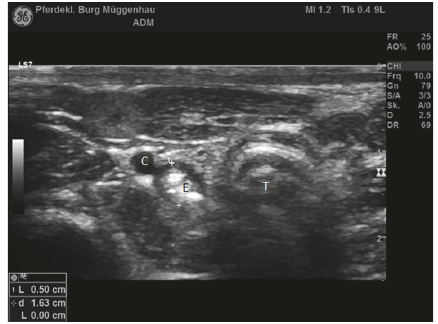
Figure 3: Ultrasound image of the stricture site. Left in the image is dorsal. A substantial decrease in diameter compared to being immediately cranial to the stricture can be observed. C: carotid artery. E: esophagus. T: trachea (probe frequency 10 MHz, depth 2,5